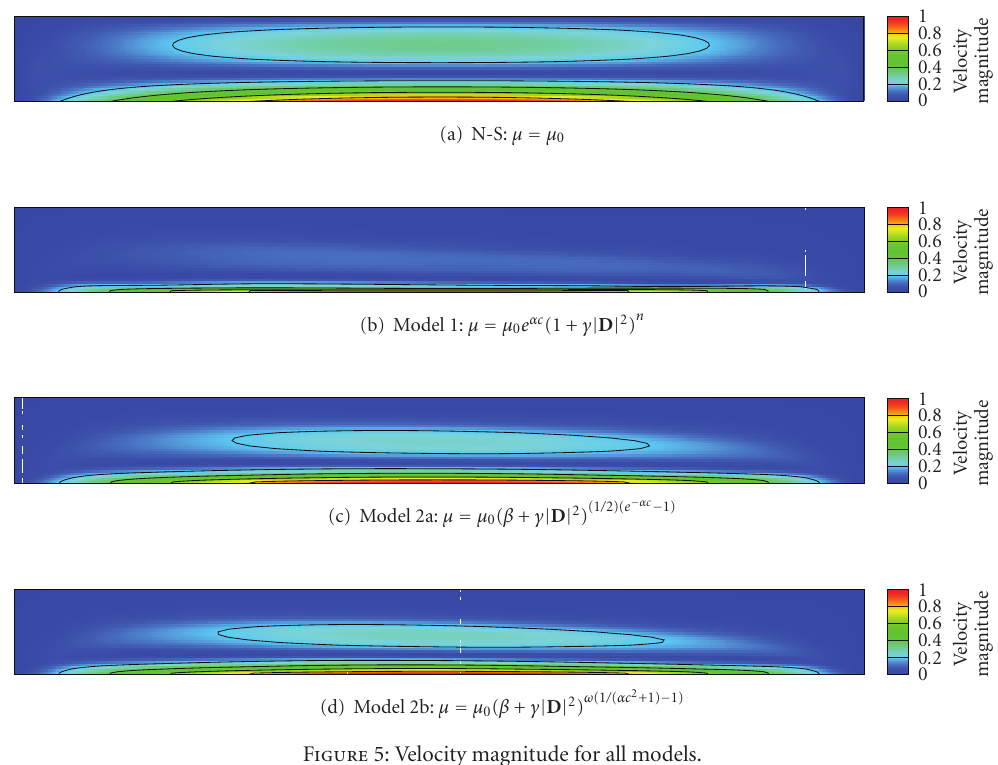
Figure 5: Velocity magnitude for all